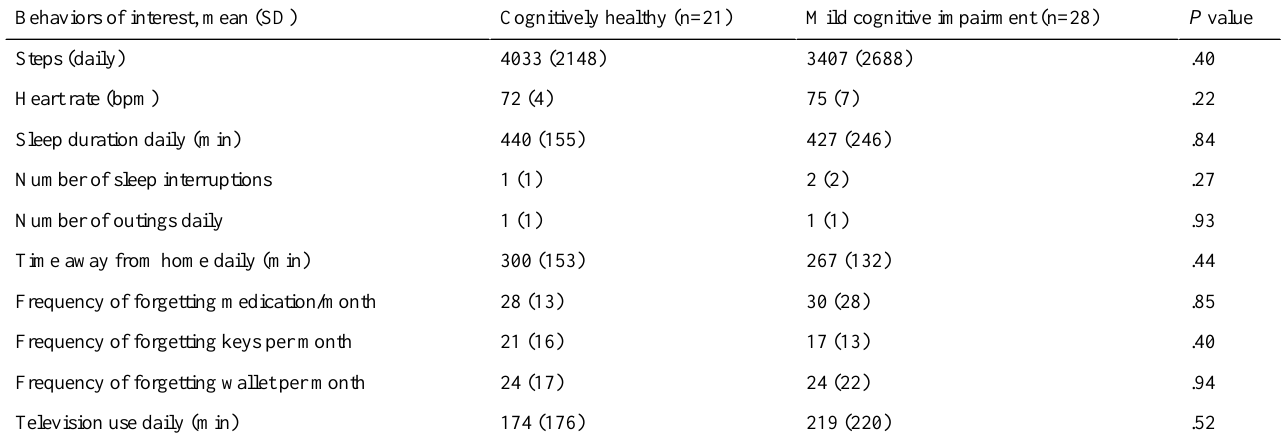
Table 2. Comparisons of activities between the cognitively healthy group and mild cognitive impairment